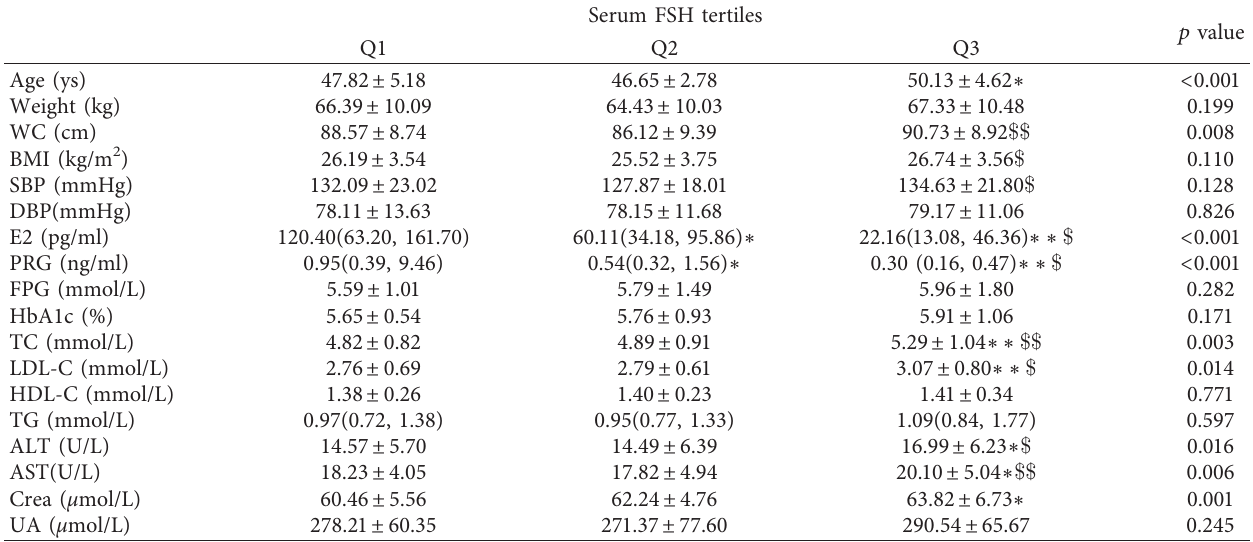
Table 3: The characteristics of the study population with different FSH levels.